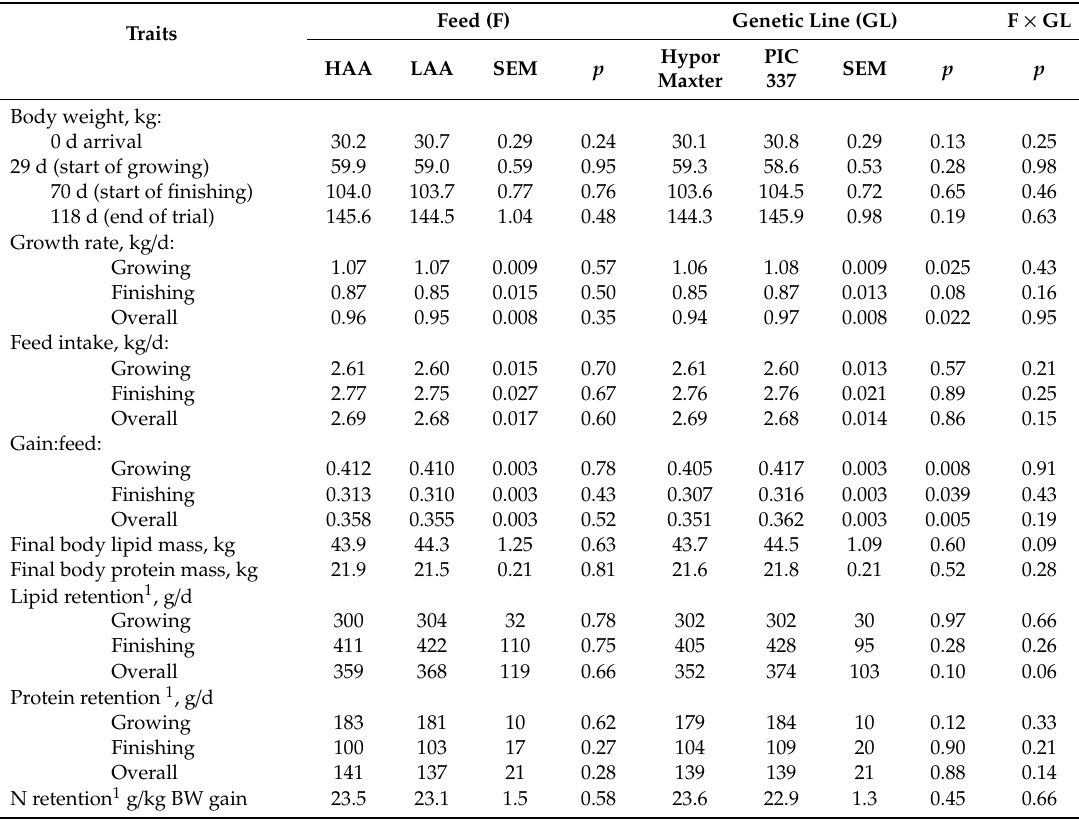
Table 3. Growth performance of barrows of two genetic lines fed high (HP) or low (LP) indispensable amino acids